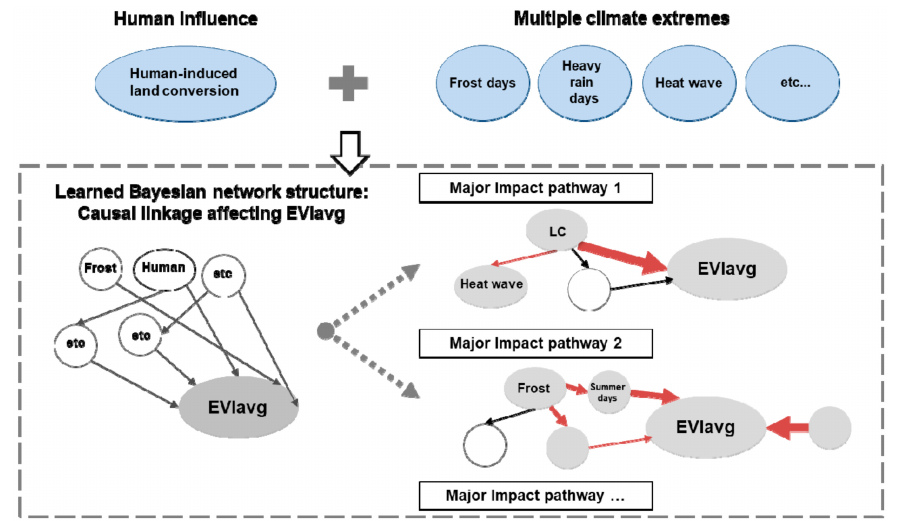
Figure 2. Conceptual framework for developing the BN (Bayesian network). Pathways of impact were analyzed by identifying the causal network. LC: Land